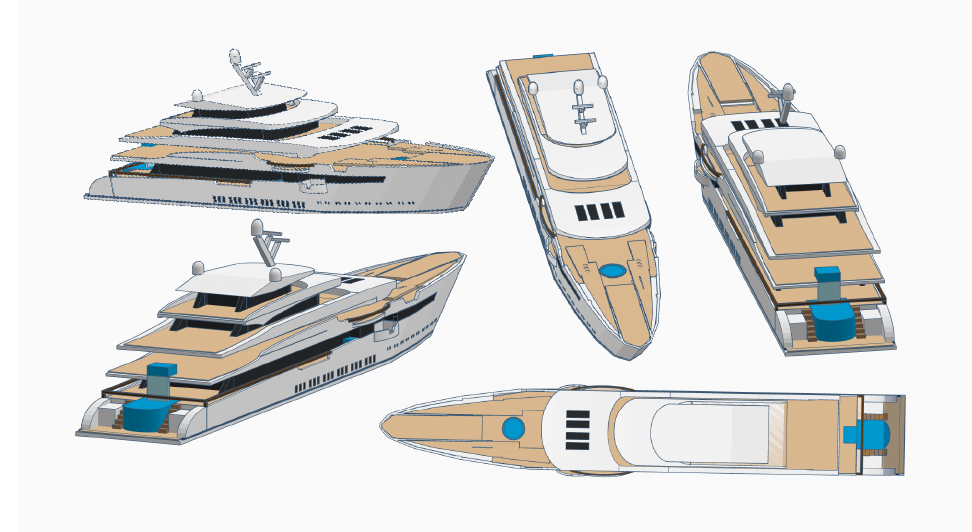
Figure 6. Different types of ship views.